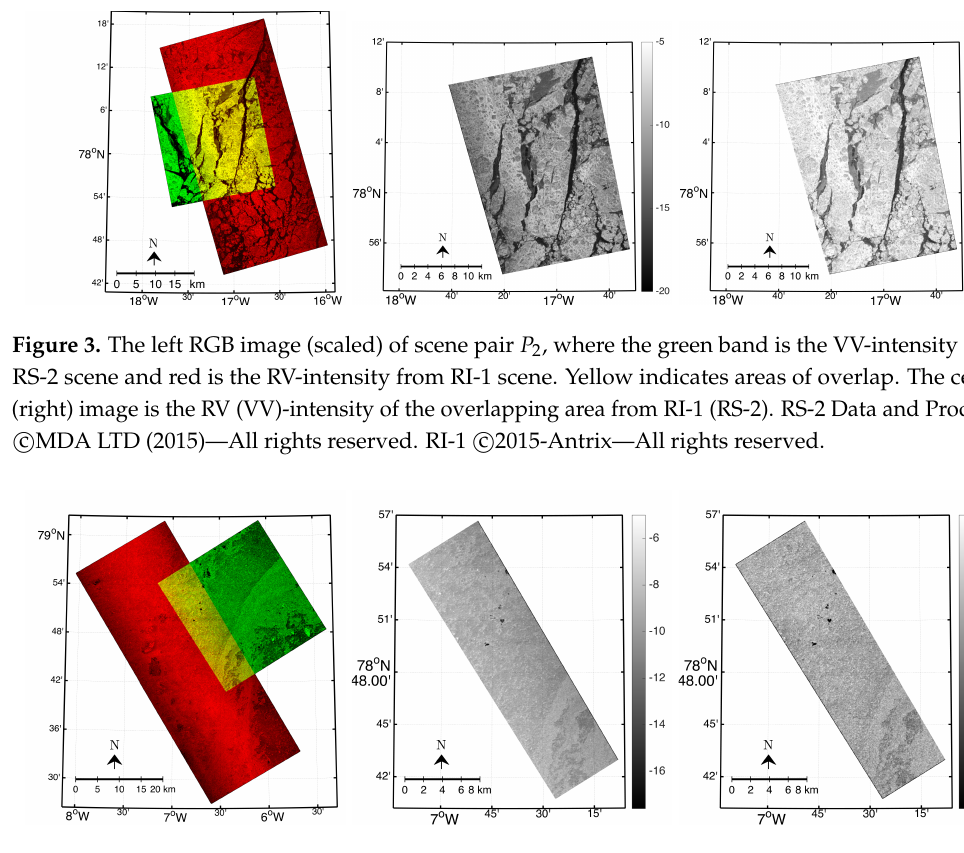
Figure 4. The left RGB image (scaled) of scene pair P 3 , where the green band is the VV-intensity from RS-2 scene and red is the RV-intensity from RI-1 scene. Yellow indicates areas of overlap. The center (right) image is the RV (VV)-intensity of the overlapping area from RI-1 (RS-2). RS-2 Data and